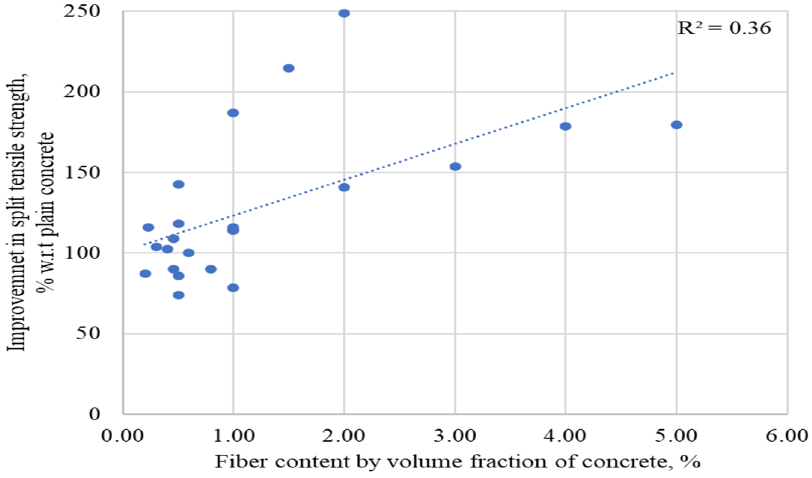
Figure 9. Percent comparison of RSF content with a percent increase in split tensile strength of RSF concrete.